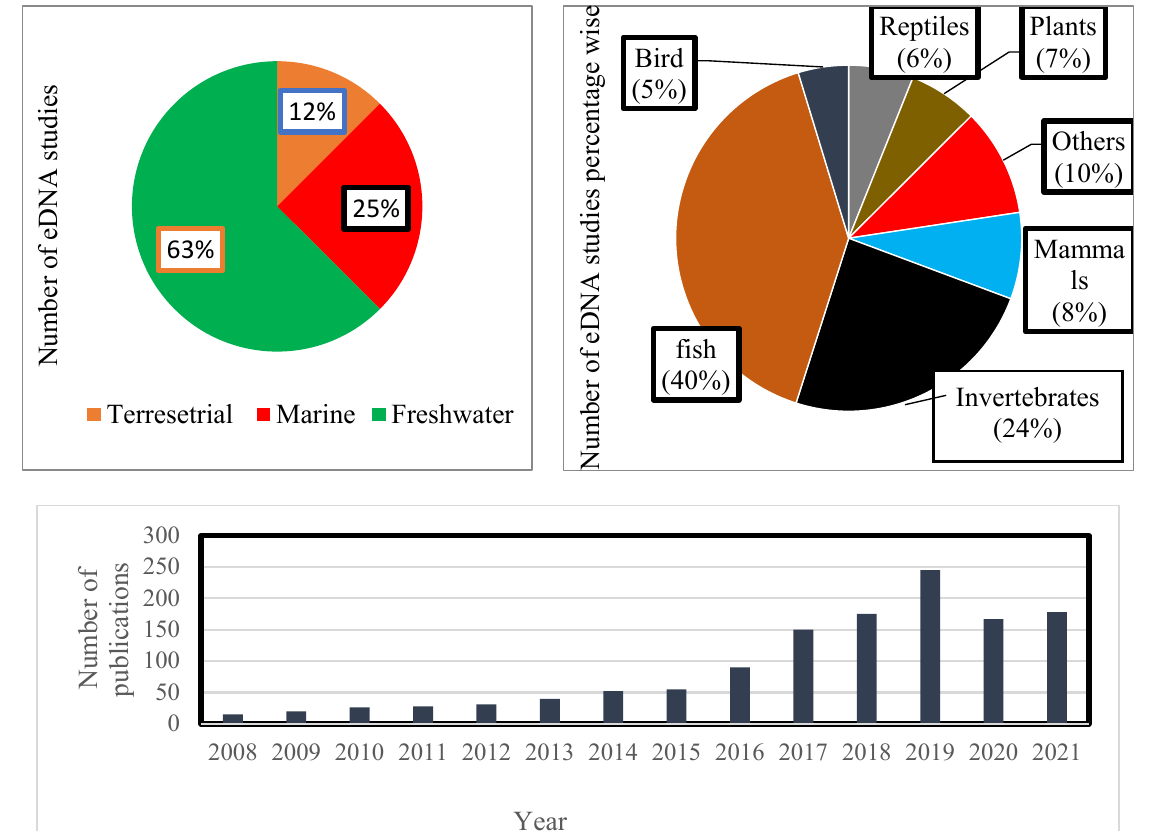
Figure 2. Overview and emergence of environmental DNA as a tool for biodiversity monitoring from “2008–2021”.